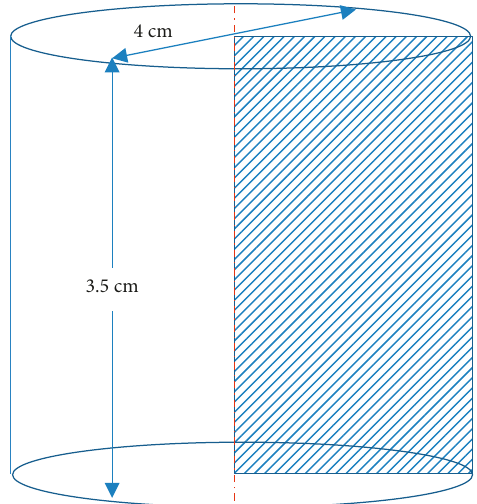
Figure 17: A clay cylinder submitted to the standard consolidation test